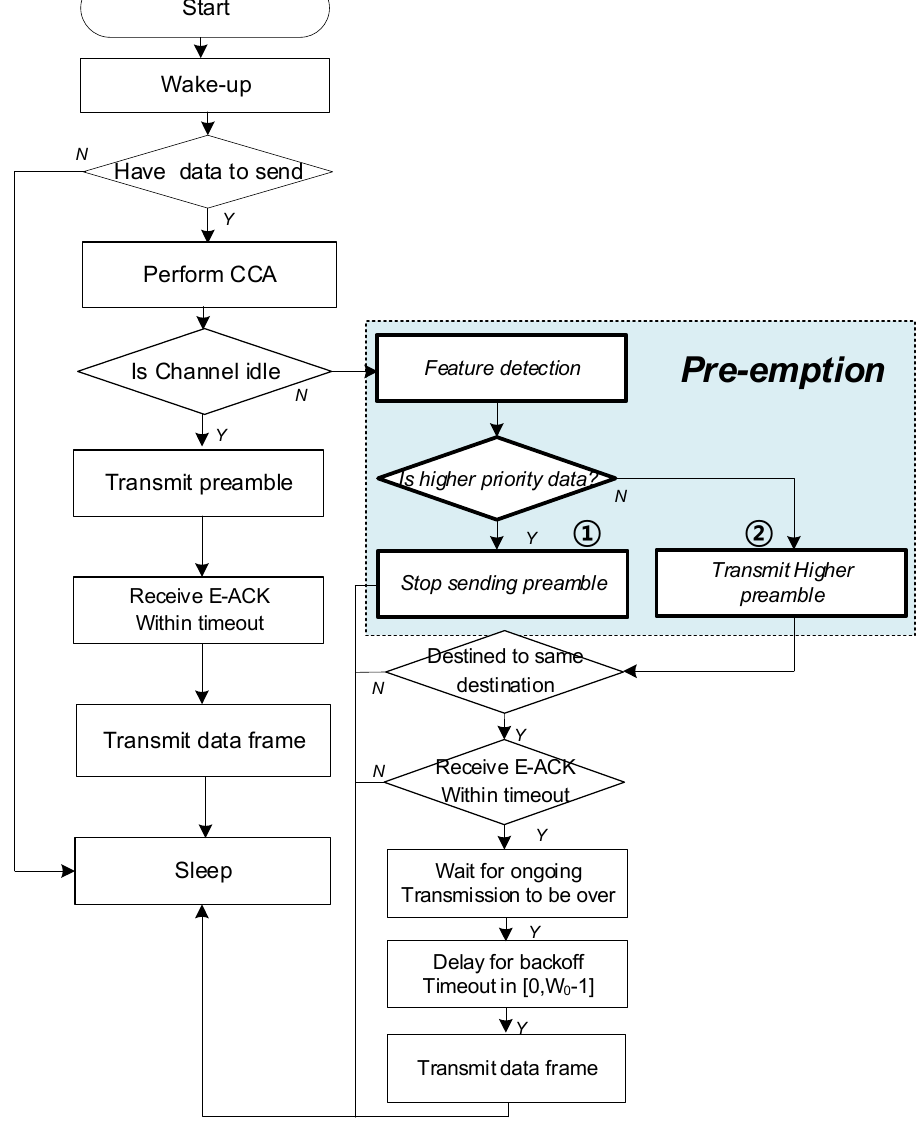
Figure 5. Pre-emption protocol algorithm.